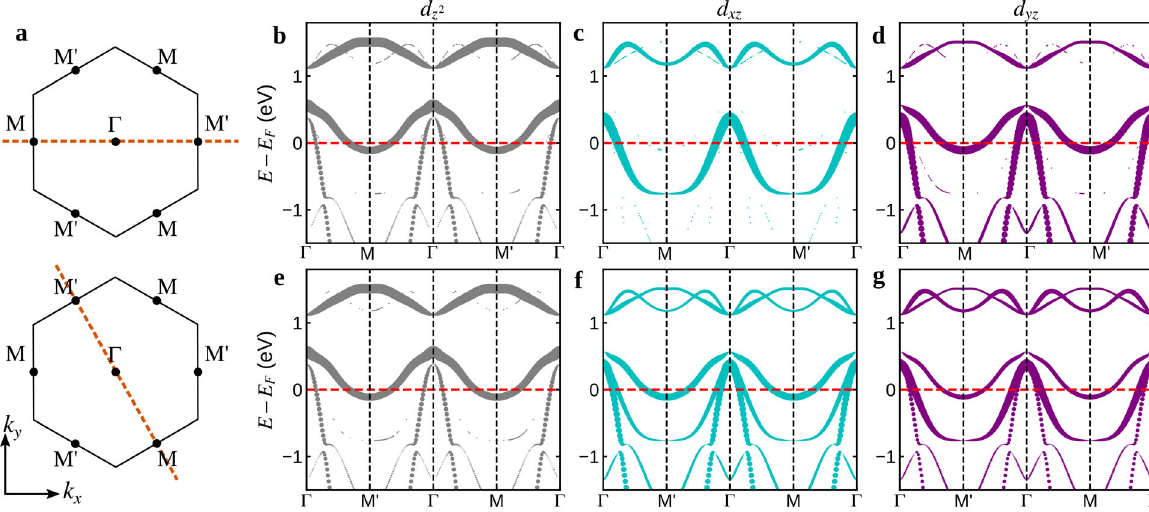
Fig. 5 Orbital-projected band structure of monolayer 1T-TiTe 2 . a First surface Brillouin zone (black) and momentum cut (dashed lines). b – d Fat-band representation of the band structure projected onto the d z 2 , d xz and d yz orbitals. The line thickness represents the weight of the respective orbital. e – g Fat-band representation of the orbital weight for the lower cut in ( a